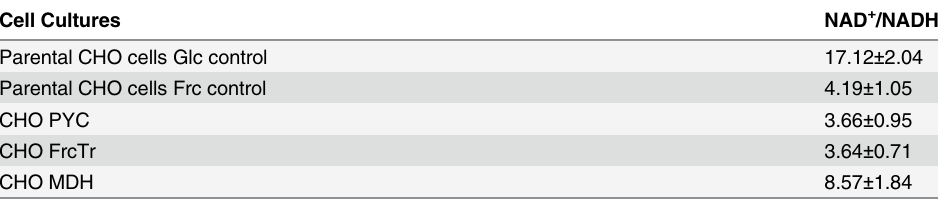
Table 3. NAD+/NADH ratios of studied